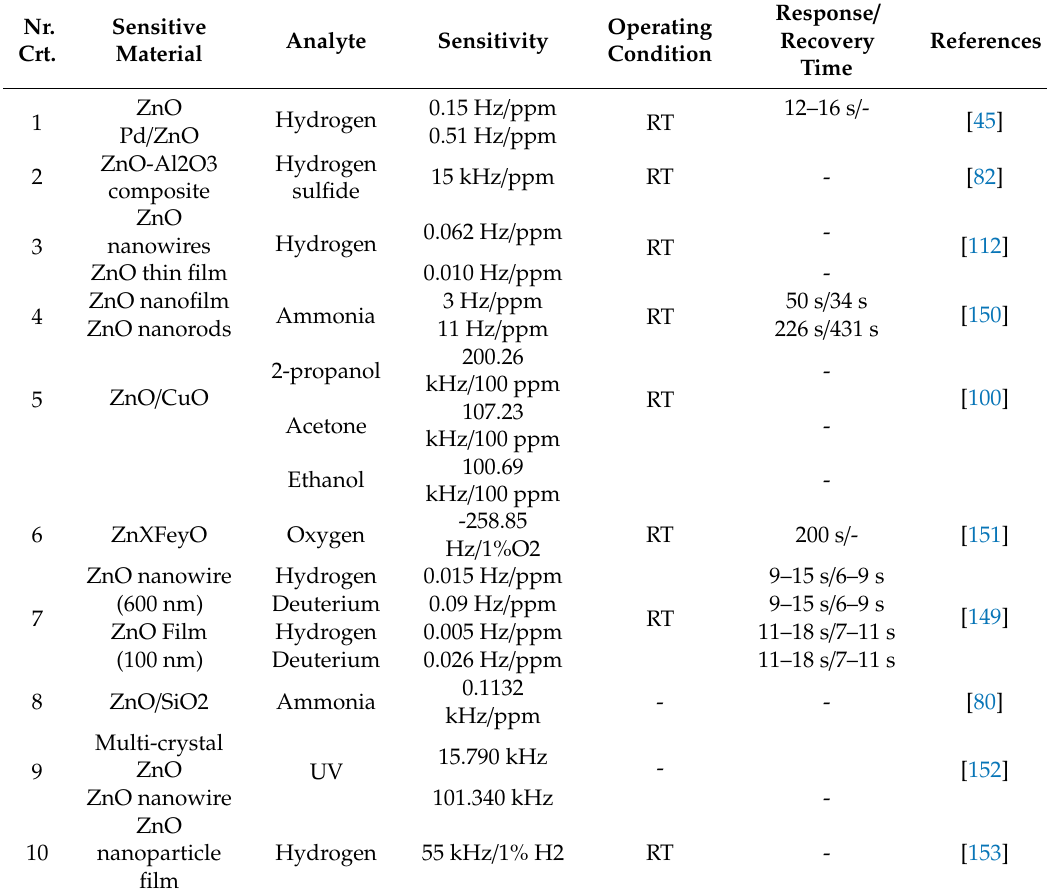
Table 2. Results of SAW sensors based on ZnO for di ff erent types of gases.